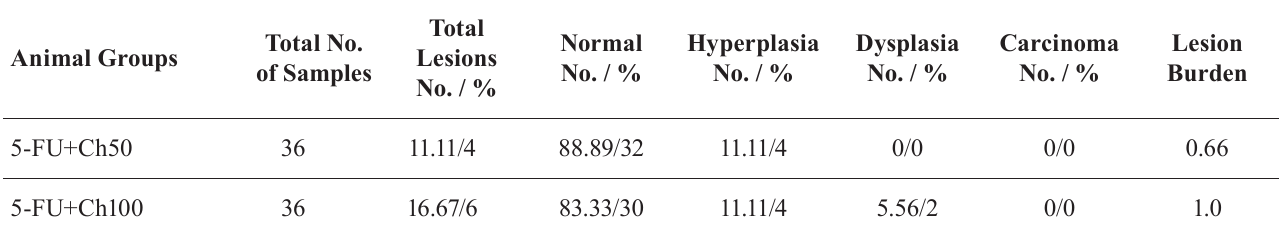
TABLE I - T he effects of 5-FU and chrysin and their combined treatments on histopathologic indexes of the colon tissue in mice receiving azoxymethane %Total Lesion BurdenCarcinoma %Dysplasia %Hyperplasia %Normal %Total No. Lesions SamplesAnimal Groups No. / No. / No. / No. / of No. / 0.660/00/011.11/488.89/3211.11/4365-FU+Ch50 1.00/05.56/211.11/483.33/3016.67/6365-FU+Ch100 Total Lesions: The number and percentage of total mice with lesions. Lesion burden: The ratio of the number and percentage of total lesions in each group to the total number of mice (n = 6). Normal: The number and percentage of samples with normal and healthy status compared to total samples. Hyperplasia, Dysplasia and Carcinoma: The number and percentage of samples with pathologic lesions compared to total samples.